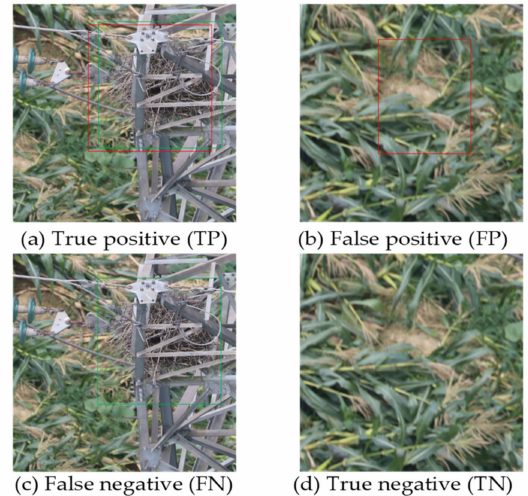
Figure 8. Practical examples of ( a ) true positive (TP), ( b ) false positive (FP), ( c ) false negative (FN) and ( d ) true negative (TN). Please note that the green box represents the label box and the red box represents the detection box.